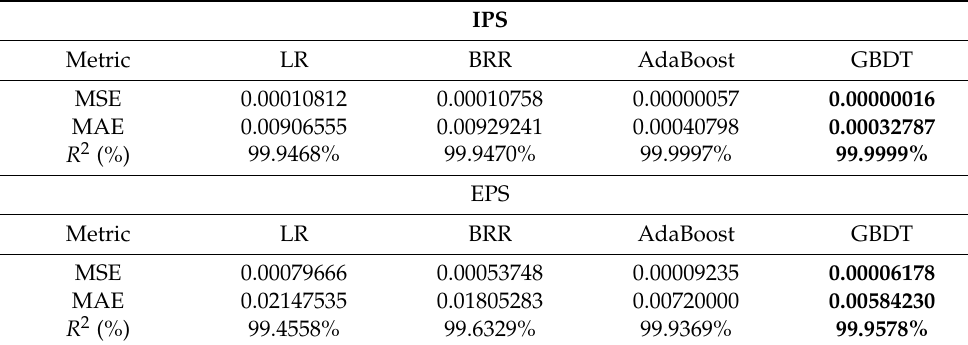
Table 2. Test performance of the